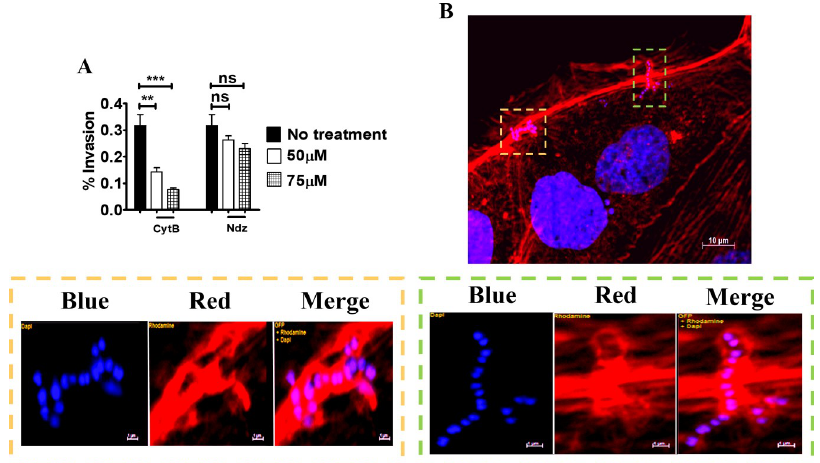
Fig 5. Actin-dependent invasion of Caco-2 cells by GBS. ( A ) Effect of cytochalasin B (CytB) and nocodazole (Ndz) on GBS invasion of 5-day-old Caco-2 islets at the non-cytotoxic concentrations of 50 and 75 μ M, respectively. Shown are means ± SD of three independent experiments conducted in triplicate �� , p < 0.01; ��� , p < 0,001 by one-way Anova and Bonferroni test. ( B ) Fluorescence microscopy analysis of 5-day-old islets infected with GBS. Scale bar = 10 μ m. The bottom panels are magnifications of the areas indicated by the two coloured dashed rectangles (orange and green). Cell-associated streptococci appear to be enveloped by actin filaments (red) below the outer edges of the cells. Scale bar = 1 μ m. Nuclei and nucleoids were stained with DAPI (Blue), actin with Phalloidin-iFluor 555 (Red).